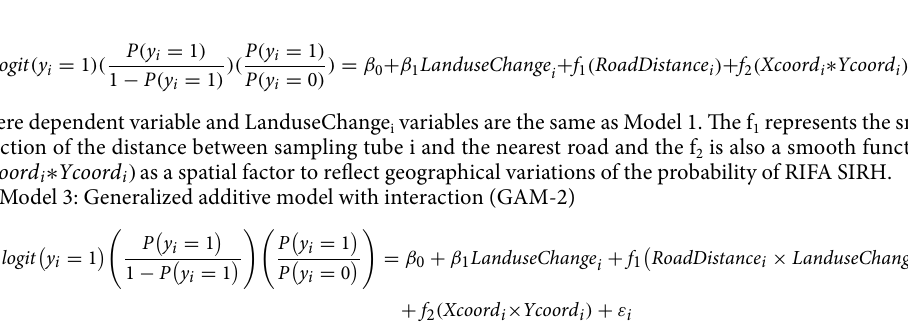
Model 3: Generalized additive model with interaction (GAM-2)